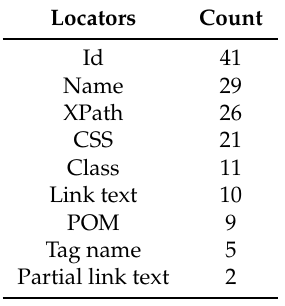
Table A4. 2.b. What locator strategy do you implement in your Selenium tests?